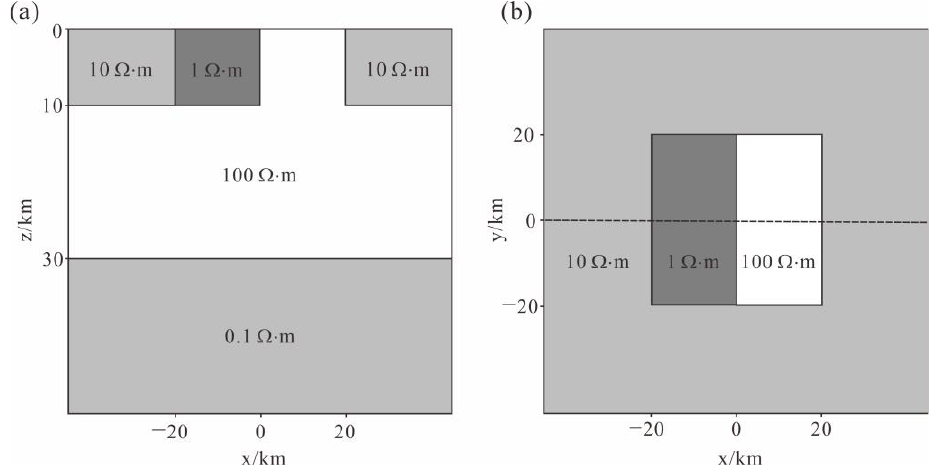
Figure 6. Diagram of COMMEMI 3D-2 model (refer to [55]). ( a ) Section view at y = 0; ( b ) plane view at z = 0. The dashed line indicates the survey line.